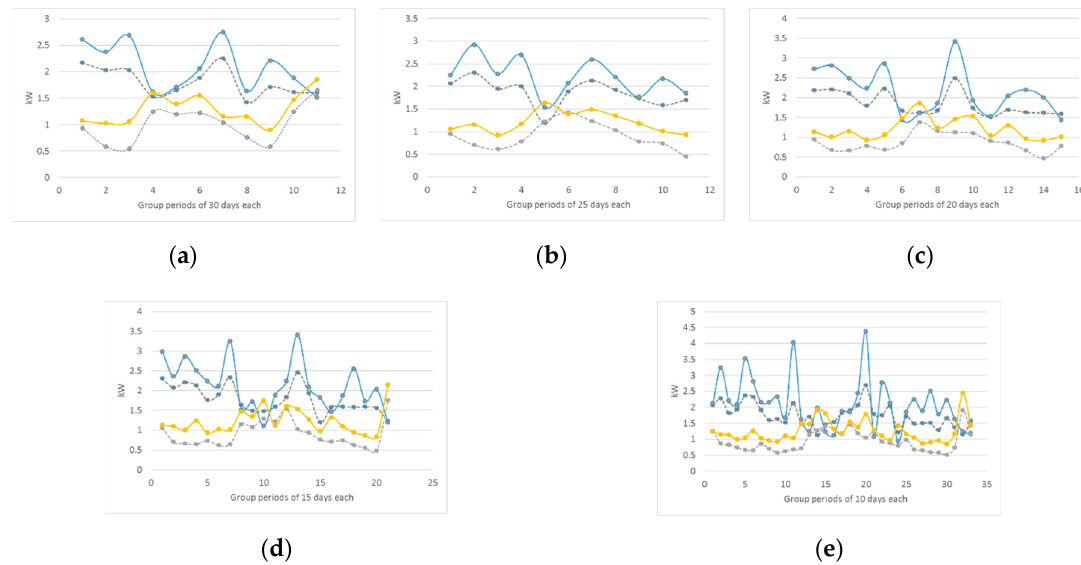
Figure 14. Estimated and measured wind power for horizons of: ( a ) 30 days ahead; ( b ) 25 days ahead; ( c ) 20 days ahead; ( d ) 15 days ahead; and ( e ) 10 days ahead. The blue and yellow lines correspond to the measured wind power in the WS and SF seasons, respectively, and the grey dashed lines correspond to the estimated wind power.